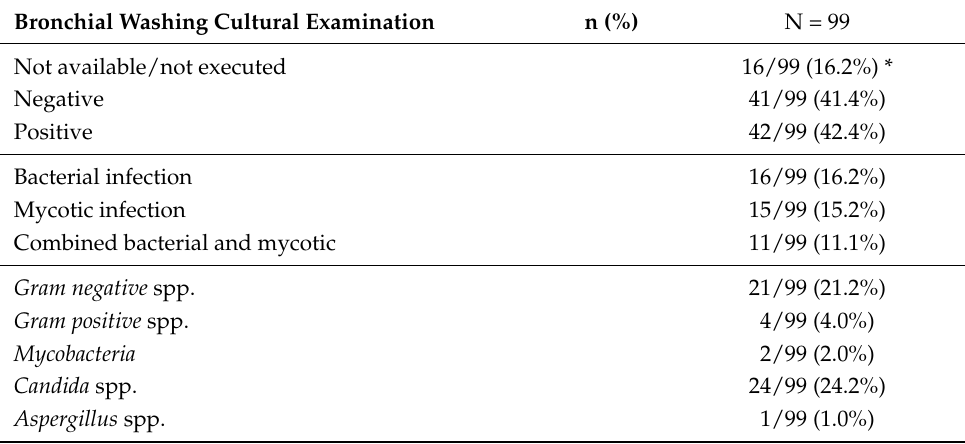
Table 6. Isolated germs from bronchial washing. * 13/16 coming from